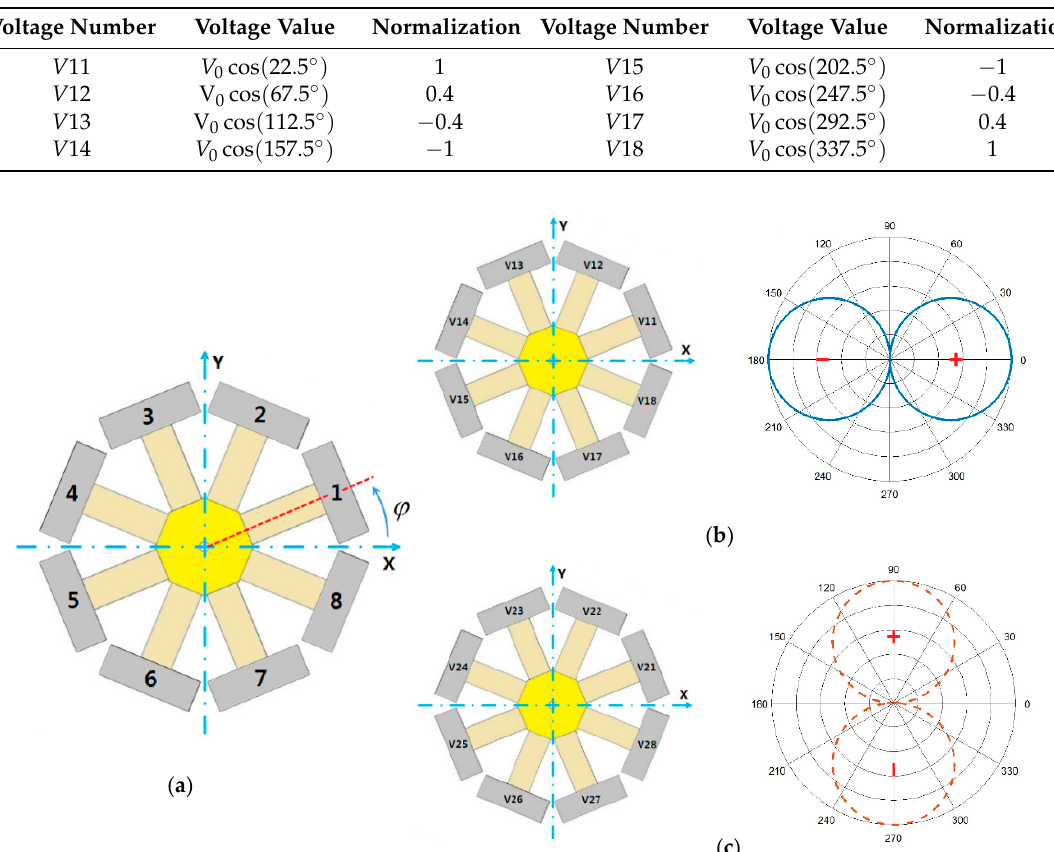
Figure 3. ( a ) The serial number of the LVPEs in the transducer; ( b ) the serial number of excitation voltages applied to the LVPEs for the dipole sound field along the x -axis and the direction of the sound field; ( c ) the serial number of excitation voltages applied to the LVPEs for the dipole sound field along the y -axis and the direction of the sound field.